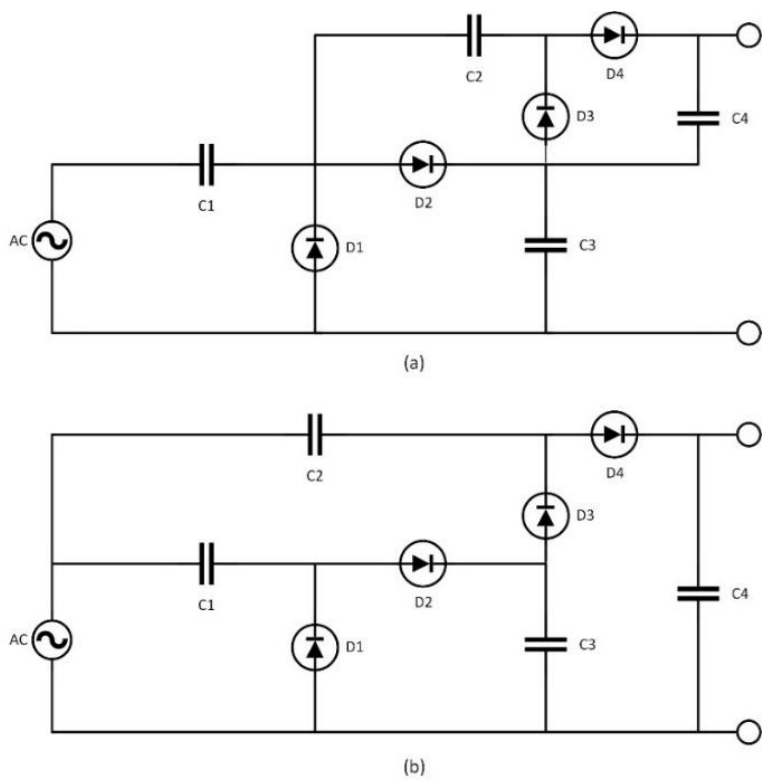
Figure 9. Topologies of voltage multipliers: ( a ) Villard Topology ( b ) Dickson Topology.